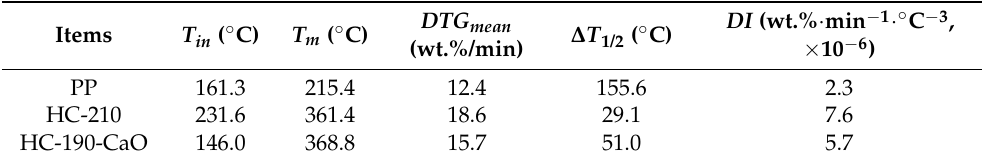
Figure 6. TG-DTG curves of PP and its derived HC products under nitrogen conditions. TG ( a ) and ( b ) DTG. Table 4. Pyrolysis parameters of raw PP and HC products.